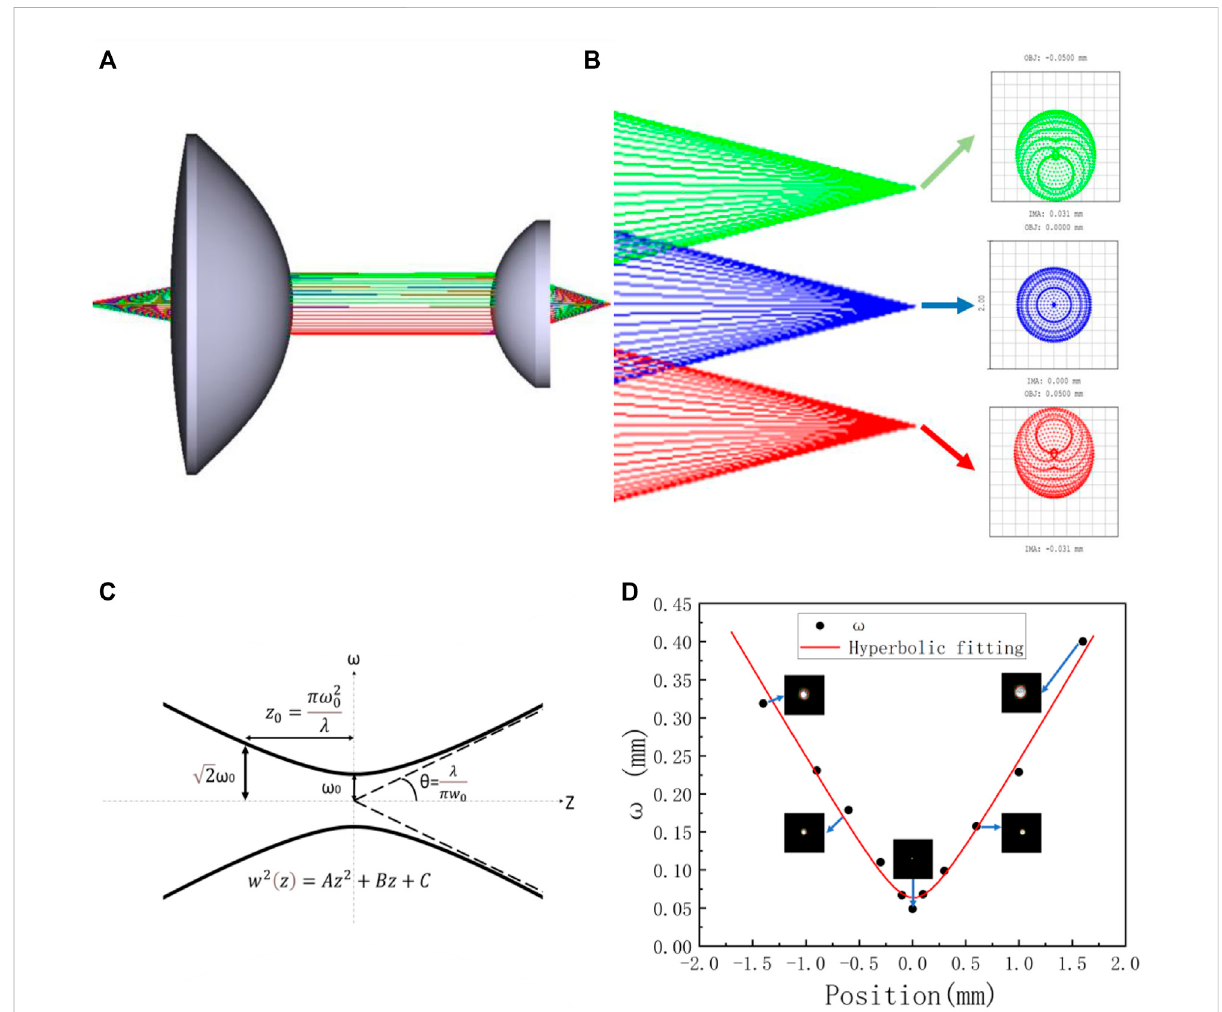
FIGURE 2 Simulationresultgraphandactualmeasurementgraphofthecombination ② + ⑥ . (A) 3DlayoutofthebeaminZEMAX; (B) focalplanelightmap and diffuse spot images corresponding to object heights of 0 and ±0.05 mm; (C) schematic diagram of Gaussian beam propagation and its parametric relationships, is the waist radius, Z 0 is the Rayleigh length, θ is the far- fi eld divergence angle, and λ is the wavelength; (D) spot radius at different positions and their hyperbolic fi ts (inset shows the spot images acquired by the CCD (VEN-161-61U3M-M05, China Daheng Group, Inc.) corresponding to each